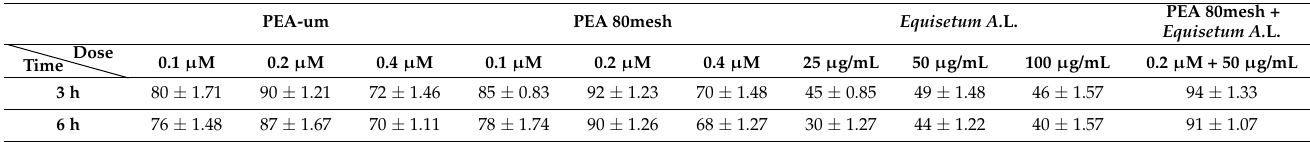
Table 1. Analysis of cell viability measured by the MTT test on CaCo-2 cells. The effects of and Equisetum A. L., both alone and combined, were compared to PEA-um at 3 and 6 h. Equisetum A.L. = Equisetum arvense L.; PEA-um = PEA ultra-micronized. The data are the mean ± SD (%) of five independent experiments performed in triplicate and normalized to control values